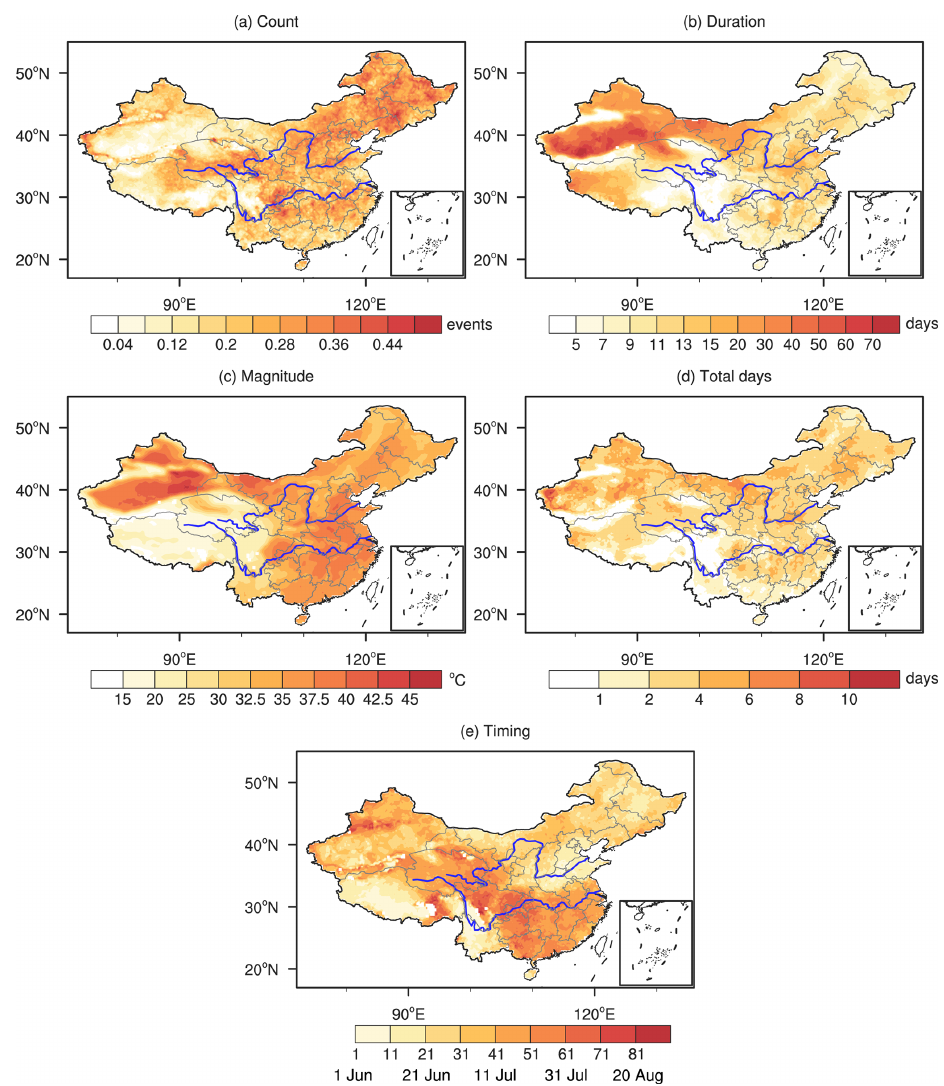
Figure 2. Maps of characteristics of grid-scale compound long-duration dry and hot events in the study area. Shown are the annual mean (a) number of events, (b) duration, (c) magnitude, (d) total number of days and (e) onset timing over the period 1961–2014. The timing is represented as the days since 1 June and 1 corresponds to 1